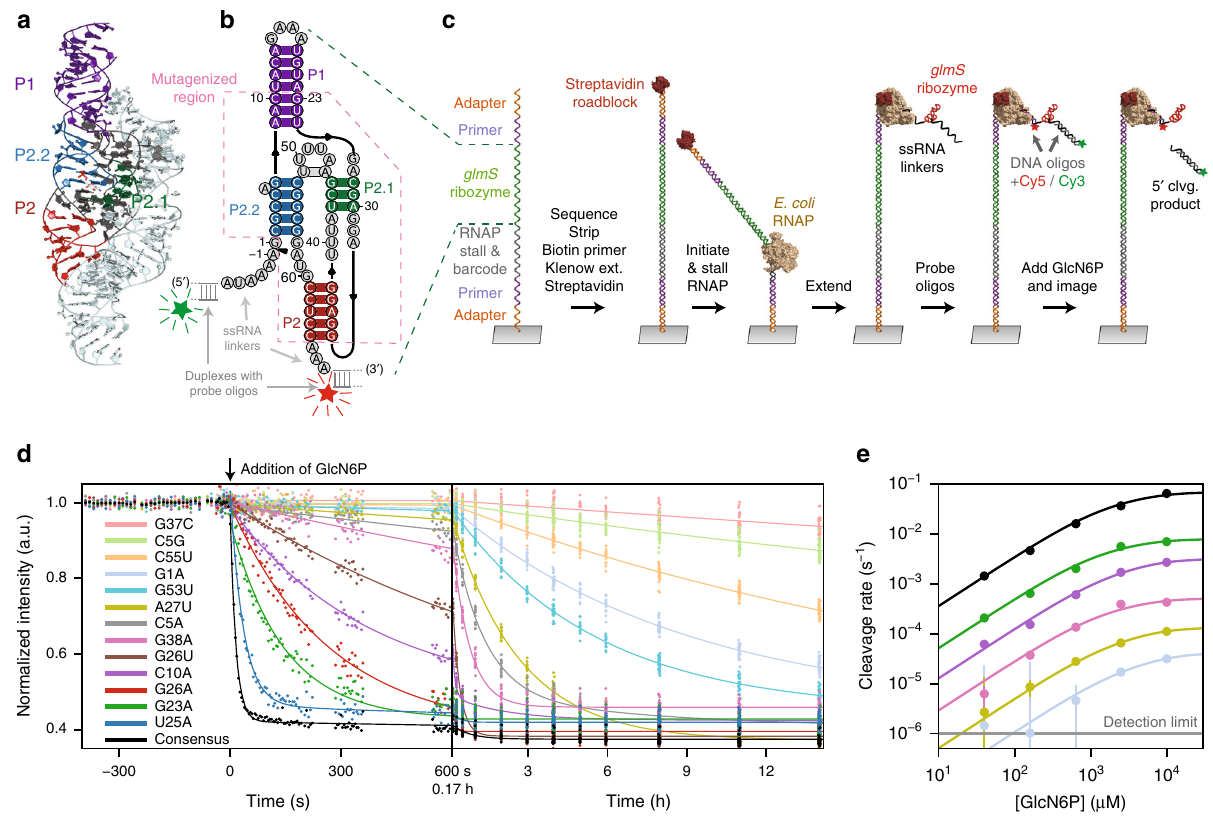
Fig. 1 RNA array assay for ribozyme self-cleavage. a Crystal structure of the T. tengcongensis glmS ribozyme, PDB 2Z75, with duplex elements P1, P2, P2.1, and P2.2 indicated (core domain: dark colors; non-core domain, pale cyan). b Secondary structure of the 66-nt core construct studied; duplex color scheme same as in a . Flanking sequences and the region targeted for random mutagenesis by doped synthesis are also indicated. The sequence of the core construct is from ref. 24 ; the secondary structure is derived from crystallographic data (refs. 11, 16 ). c Schematic of sequential steps for the RNA array assay. Variants were transcribed in situ on a sequencing chip. Hybridized Cy3- and Cy5-dye labeled DNA oligomers scored the presence of the ribozyme. The Cy3 TIRF signal is lost upon cleavage, which releases the 5 ′ product. d Representative cleavage records for the consensus ribozyme and the 13 variants are indicated (color-coded), displayed on both short and long time scales (data points are median per-tile intensity values for the given variant). e , Representative Michaelis – Menten curve fi ts to cleavage rates, derived from RNA array data (as in d ), as a function of GlcN6P concentration (error bars, std. err.). Same color code as in panel d . Source data are available in the Source Data fi